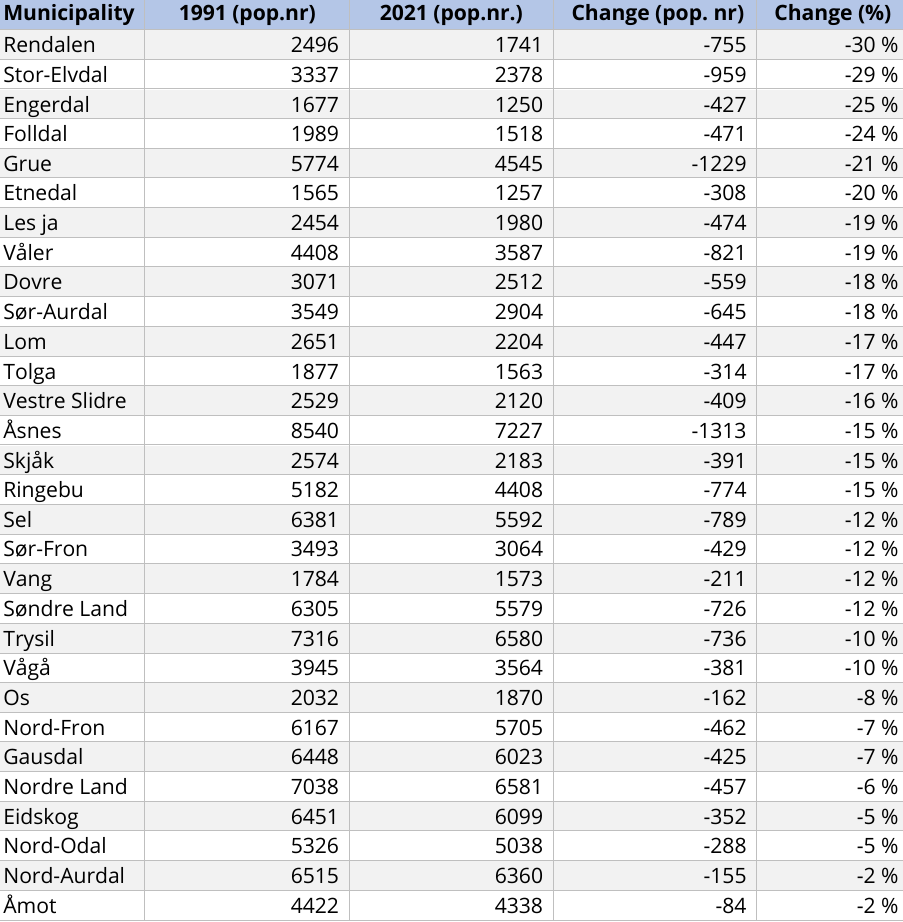
Table 1. Population numbers and change in numbers and percentage (%) 1991–2021. Municipalities in Innlandet County and Innlandet. Sorted by %-change. (Source: Statistics Norway